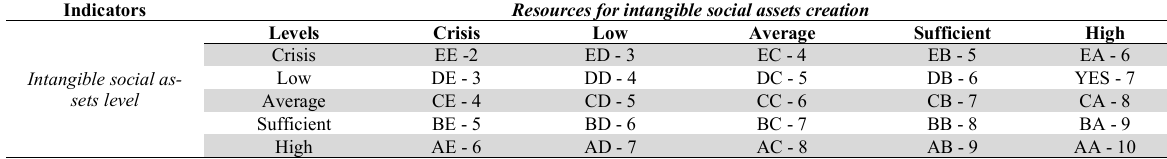
Matrix of enterprise’s social assets levels Indicators Resources for intangible social assets